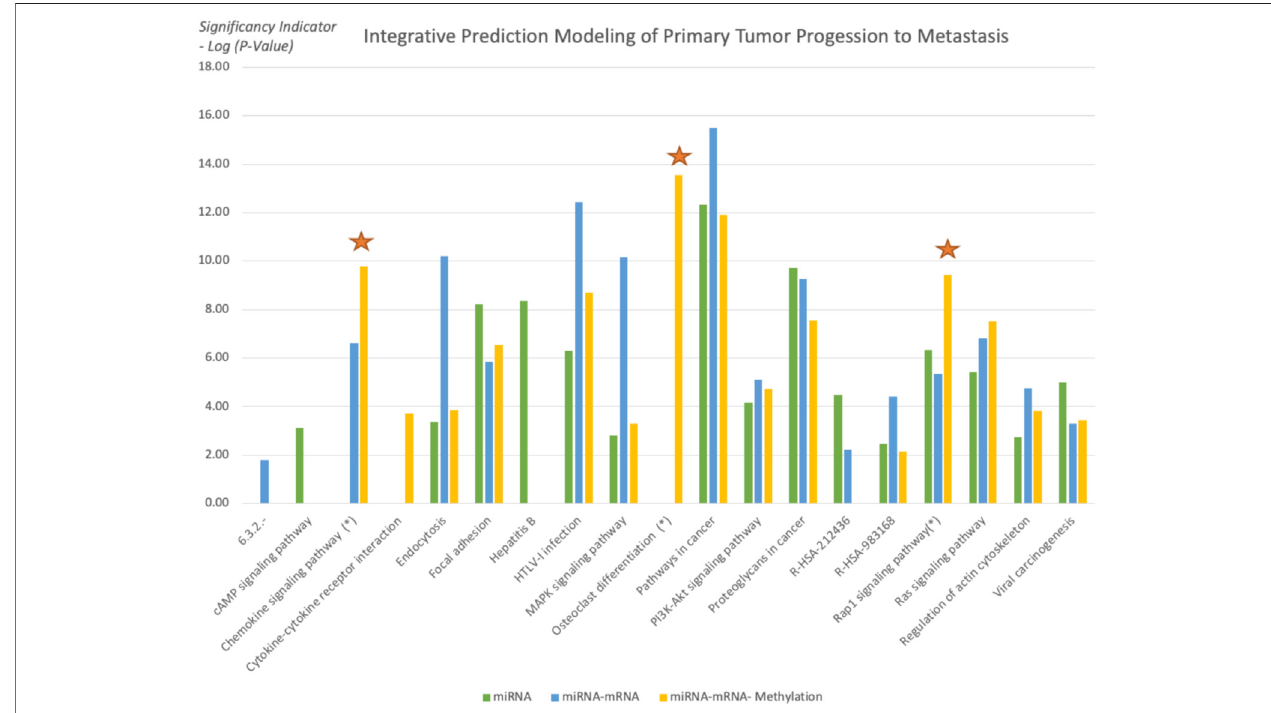
FIGURE 10 | Signi fi cant pathways functionally enriched in all three feature sets. As the new biomarker set is added, the signi fi cance of the pathways is evaluated. Osteoclast, Rap1 signaling pathway, and chemokine signaling pathways showed a signi fi cant increase in the third model.